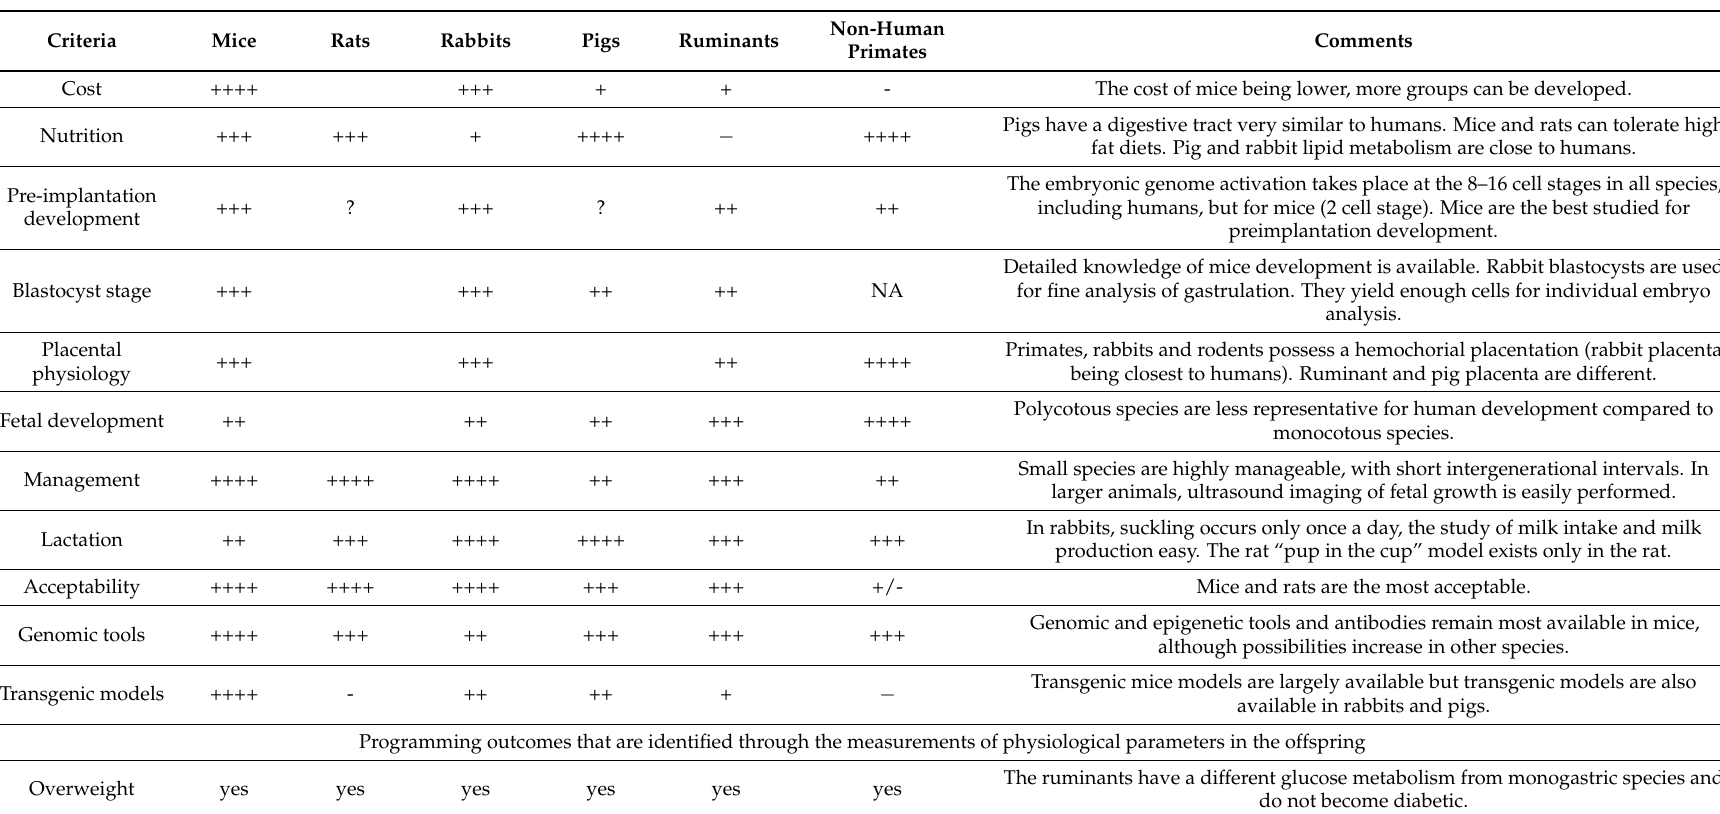
Table 1. Pertinence of animal models and availability of tools classified from ´ (very little advantages) to ++++ (very advantageous or largely available). ?: no (or very few) data available; NA: not applicable. It must be noted that with the development of genome editing in mammalian species, transgenic models are quickly becoming easily available and reasonably priced in non-rodent